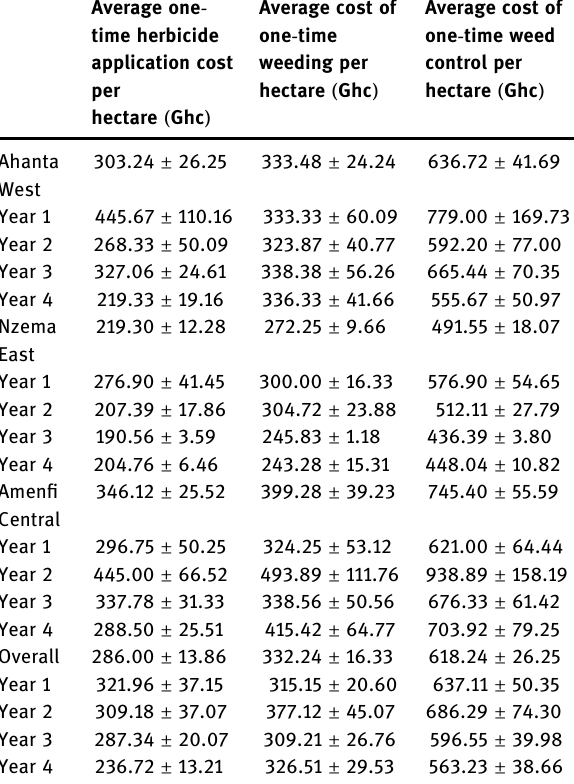
Table 4: Average fi nancial cost of one - time weed control incurred by smallholder rubber plantation farmers in the Western Region of Ghana. All amounts are in ( Ghc ) Average one